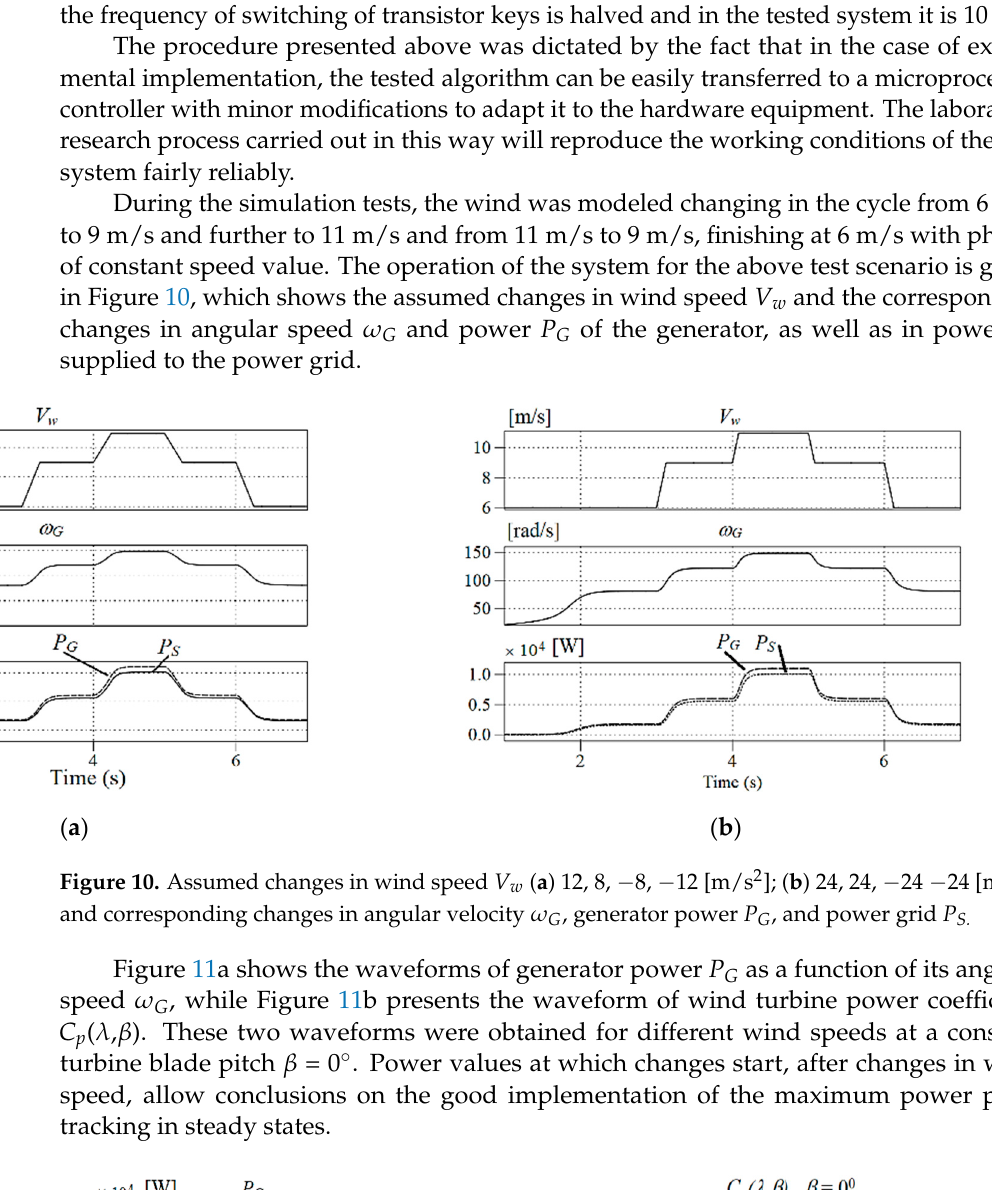
( b ) Figure 11. Waveforms of generator power P G ( a ) and turbine power coefficient C p ( λ , β ) ( b ) for chang- ing wind speed V w and blade angle equal to β = 0°.